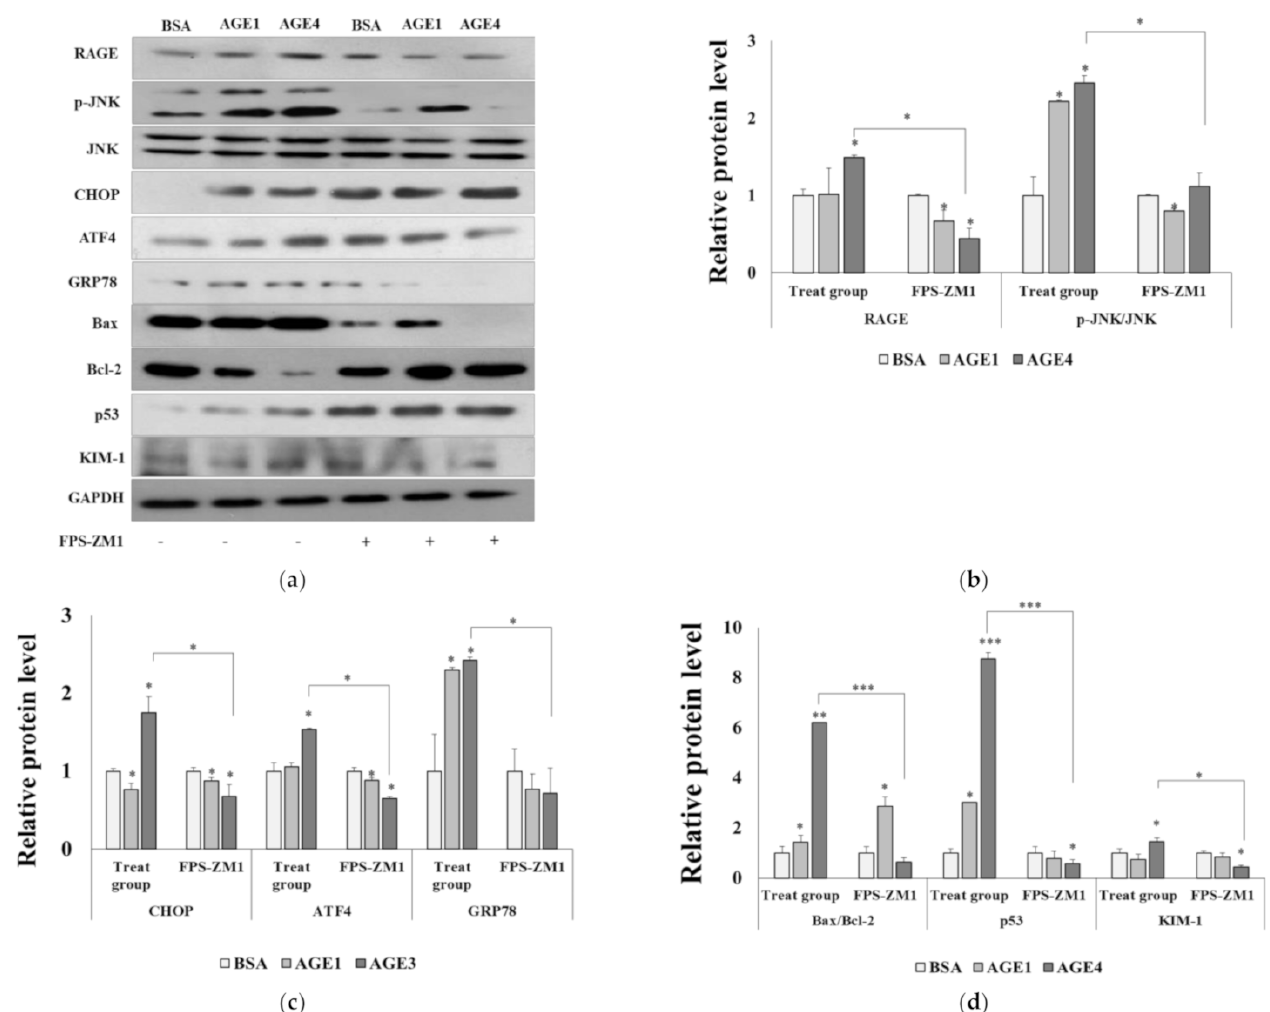
Figure 3. Effects of AGE4–RAGE axis on the ER stress and apoptosis in HK-2 cells. ( a ) After pretreatment with a selective RAGE inhibitor (10 M FPS-ZM1) and AGE4 (200 g/mL, 24 h), the protein expression levels of RAGE, p-JNK, JNK, CHOP, ATF4, GRP78, Bax/Bcl2, p53, and KIM-1 were determined by Western blotting. ( b – d ) Densitometric analysis was performed using ImageJ, and the ratio of the expression of the target protein to that of GAPDH was calculated. Plus sign represents the presence of FPS-ZM1. Minus sign represents the absence of FPS-ZM1. Data are expressed as the mean ± standard deviation (SD) of at least three independent experiments. The groups were compared using a Student’s t -test, and the levels of statistical significance are indicated as follows: * p < 0.05, ** p < 0.01, and *** p <